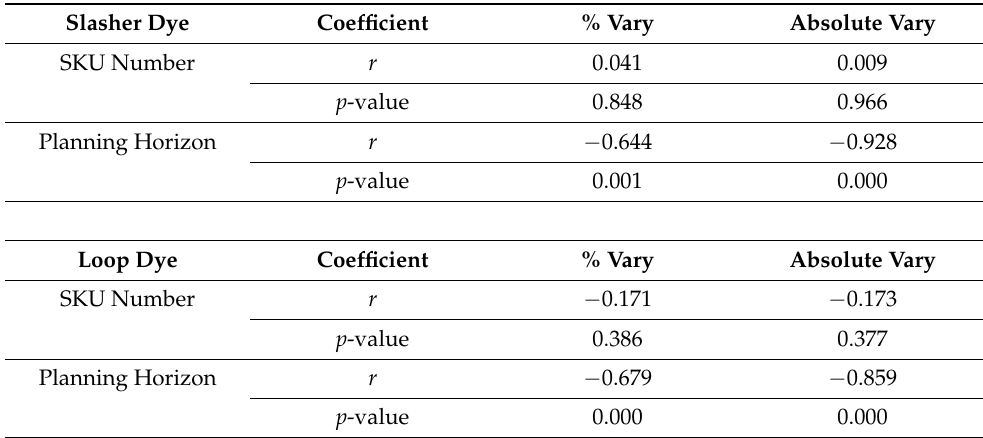
Table 7. Linear Correlation